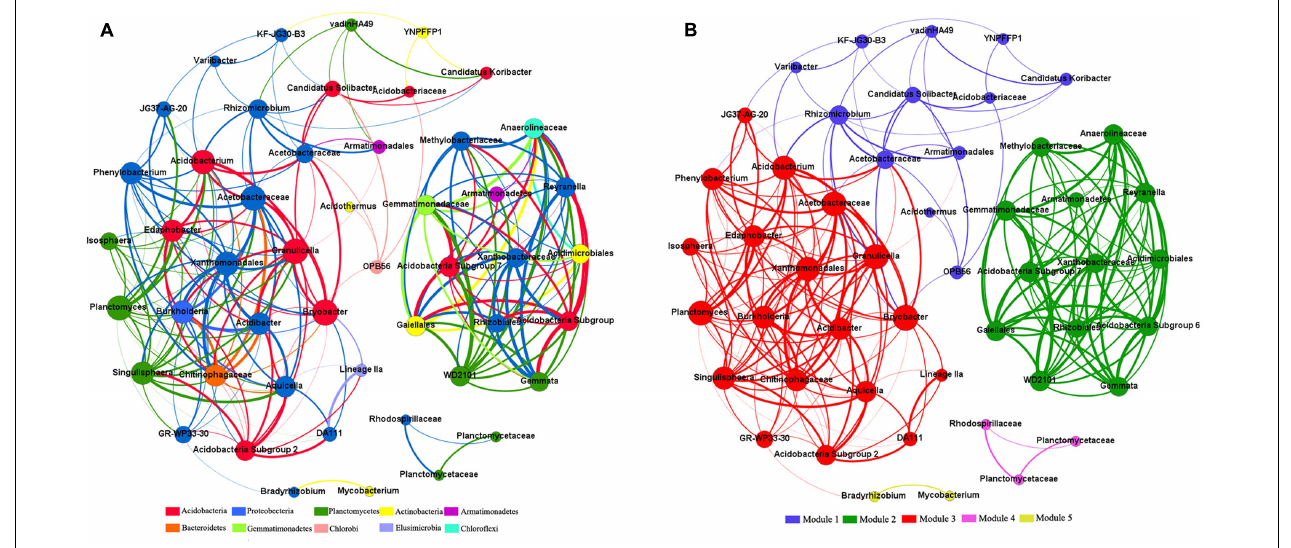
FIGURE 5 | Co-occurring network of bacterial communities across five vegetation types based on correlation analysis. The nodes in network (A) are colored by phylum. The nodes in network (B) are colored by modularity class. The connections stands for a strong (spearman’s ρ > 0.6) and significant ( P < 0.01) correlations. The size of each node is proportional to the relative abundance of specific genus. The thickness of each edge is proportional to the ρ .